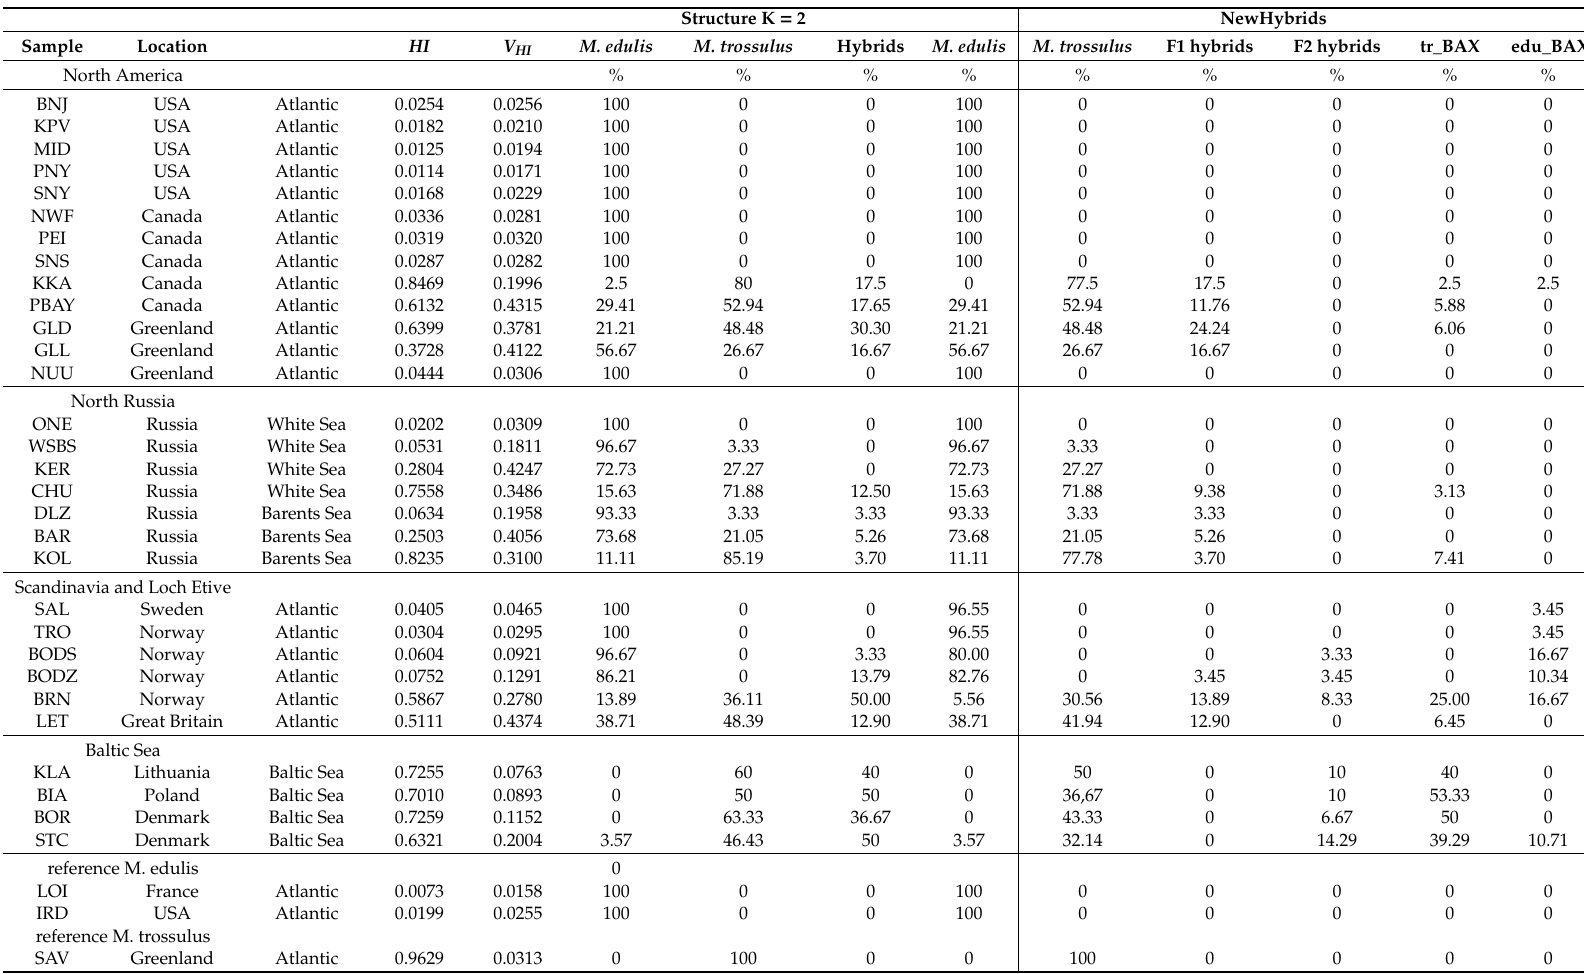
Table 3. M. trossulus × M. edulis hybrid